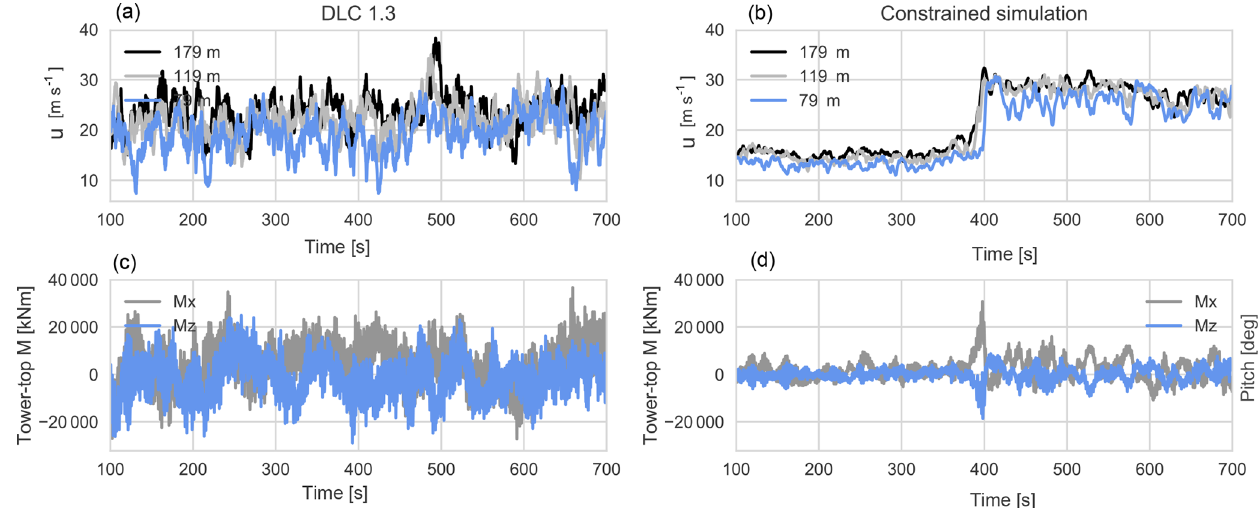
Figure 11. Comparison of a DLC 1.3 time series (a, c) and a constrained simulation time series of an extreme event (b, d) . (a, b) The u component wind speed. (c, d) Tower-top tilt (grey) and yaw (blue)